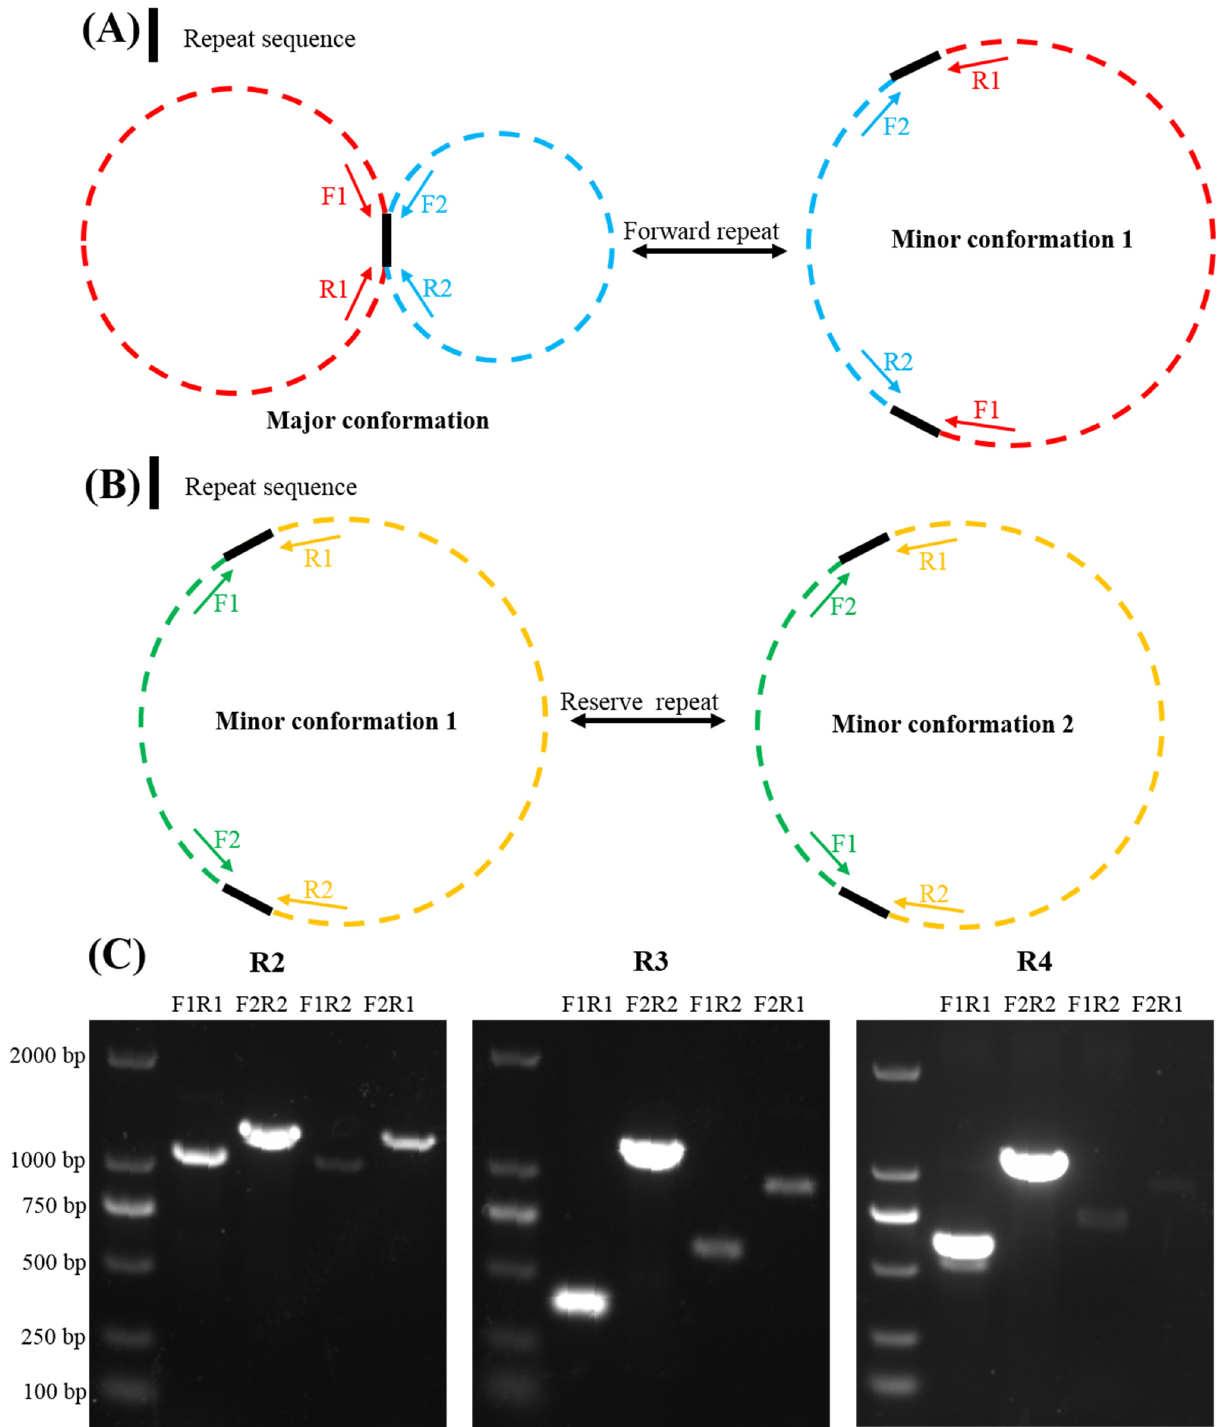
Figure 4. Validation of the homologous recombination mediated by different pair repeats. ( A , B ) The schematic diagram of primer design and experimental design after reverse primer exchange of direct repeat sequences that can mediate homologous recombination in representative circular molecules. ( C ) PCR validation results of the existence of various conformations of mitochondrial DNA. From left to right, each of the five lanes represents a set of three experiments, namely, repeat2, repeat3, and repeat4. The experiments are as follows, from left to right: marker, major conformation 1, major conformation 2, minor conformation 1, and minor conformation 2.